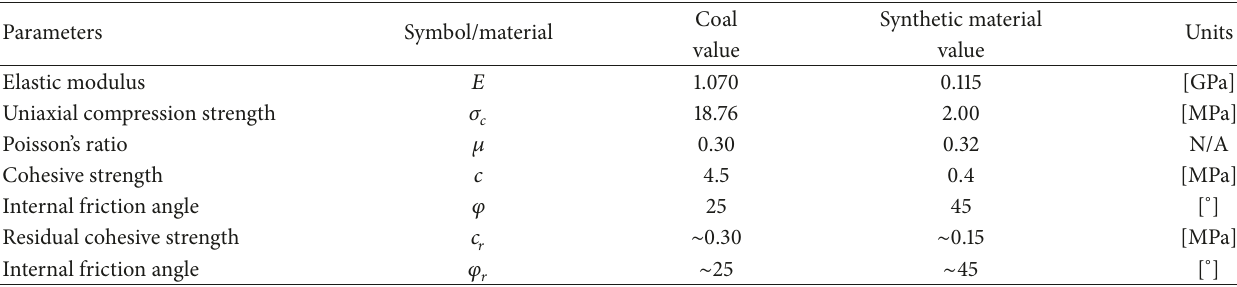
Figure 5: Plane-strain biaxial compression test system. (a) Schematic of test system; (b) paragraph of the experimental set-up. Table 1: Mechanical and physical parameters of specimens.